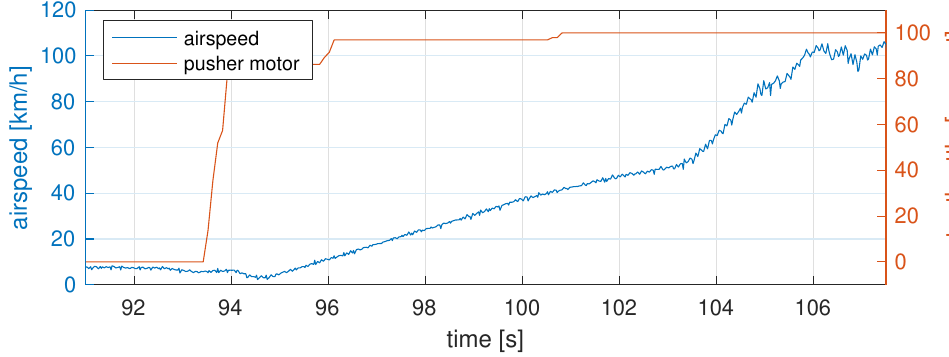
Figure 30. Telemetry log from an in-flight experiment: top speed test in a horizontal flight in Elka1Q